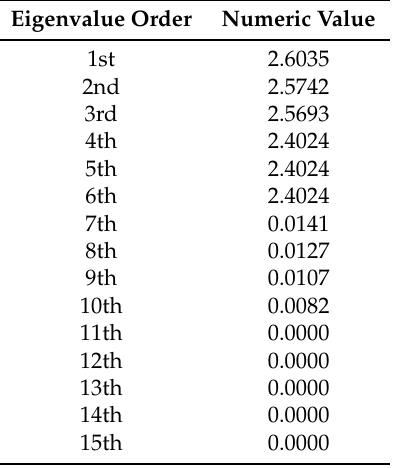
Table 4. Stationary eigenvalues ( t = 60 min) of the covariance matrix in the experimental test.